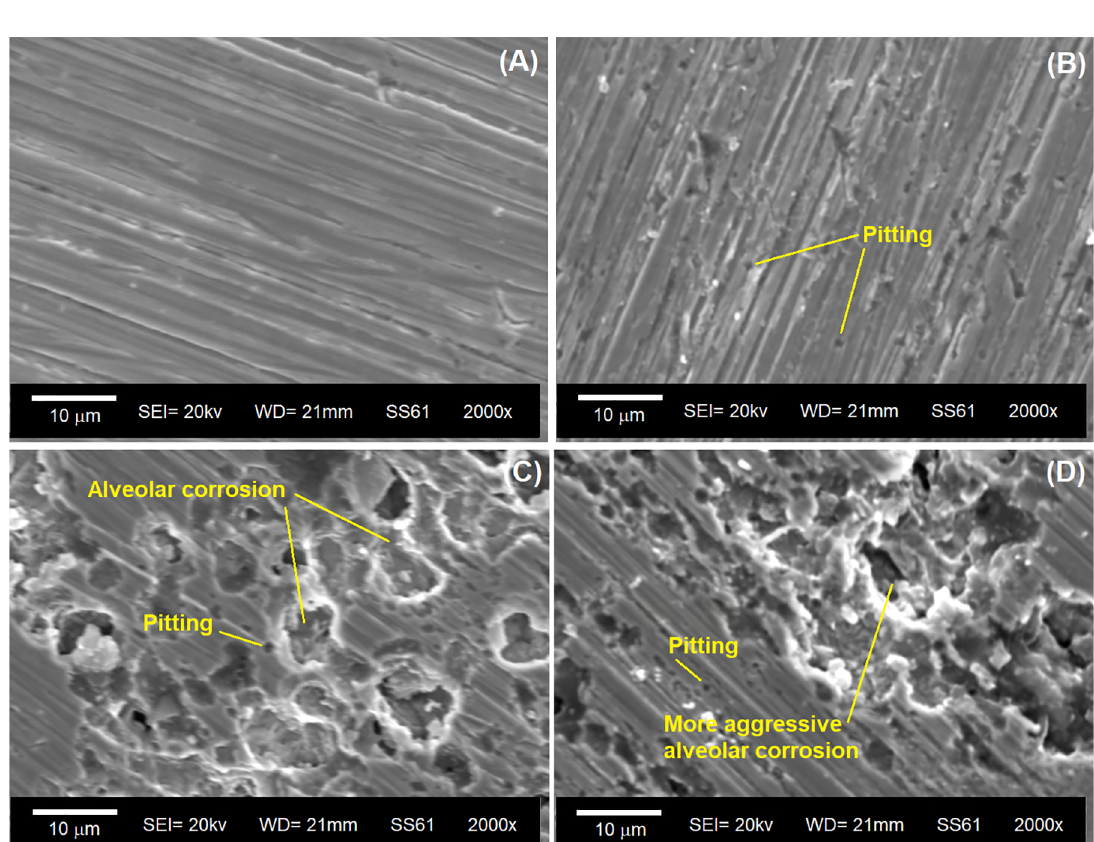
Figure 4. SEM micrographs of the AISI 1020 steel (A) untested sample and immersed in (B) heavy, (C) medium and (D) blend